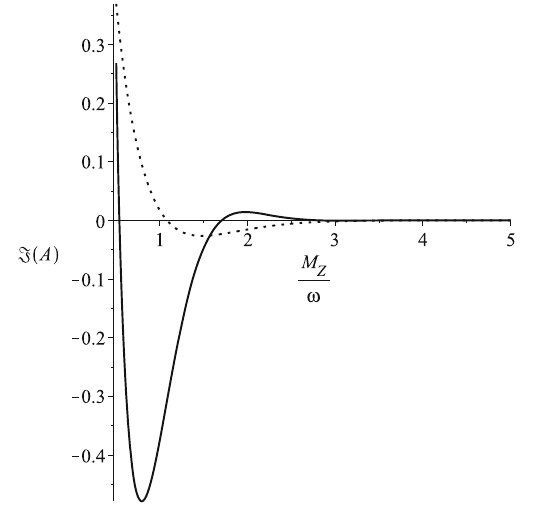
Fig. 5 | B k | 2 as a function of parameter M Z /ω . Solid line is for p = 0 . 5 , p (cid:11) = 0 . 4 , P = 0 . 1, while the point line is for p = 0 . 5 , p (cid:11) = 0 . 3 , P = 0 .